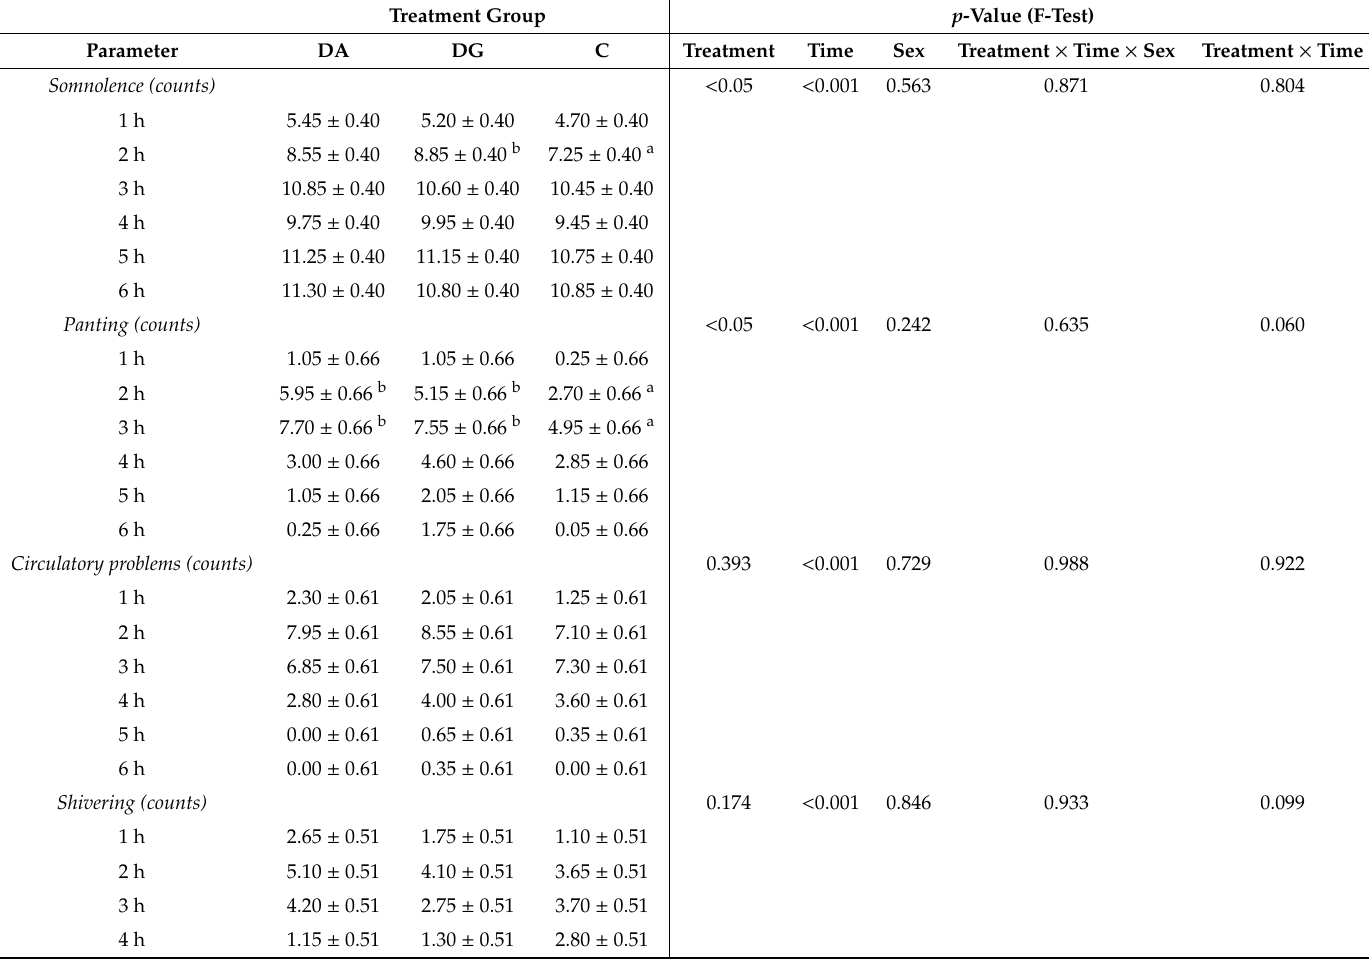
Table 1. Occurrences of parameters indicative of sickness behaviour in piglets of di ff erent treatment groups after LPS application. Treatment